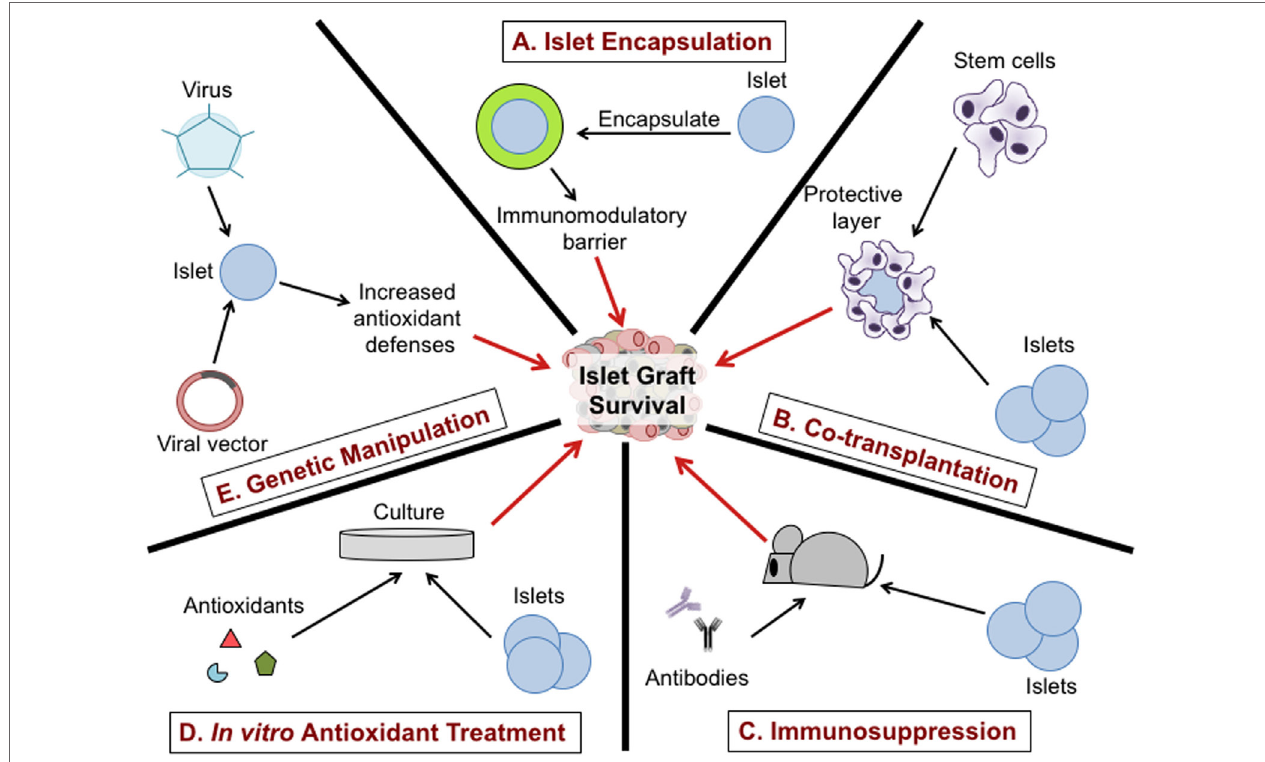
FigURe 3 | Therapeutic approaches to protect islet graft viability. Encapsulation of purified islets provides a physical and potentially immunomodulatory barrier between the islet graft and the host immune system (A) . Co-transplantation of stem cells or regulatory immune cells with the islet graft can reduce immune infiltration to the graft (B) . The use of immunosuppressive drugs such as monoclonal antibodies specific for immune cell subsets can suppress inflammatory responses in the host and prolong graft survival (C) . Treatment of purified islets with antioxidants during culture can dissipate free radicals involved in islet dysfunction and viability, may enhance engraftment and delay graft rejection (D) . Transfection of purified islets using a virus or viral vector to increase antioxidant defenses can promote islet graft viability and prolong survival after transplantation (e)